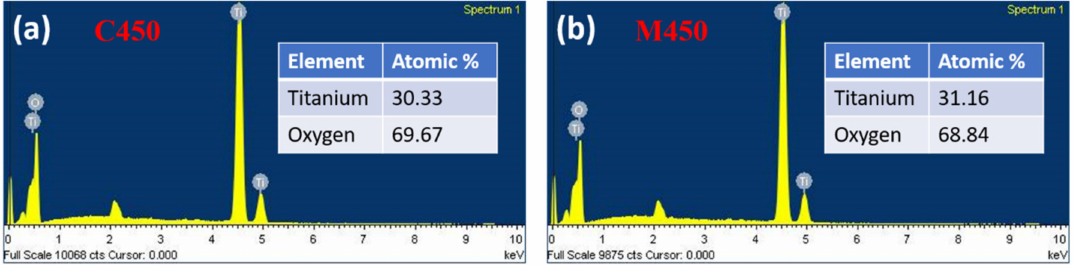
Figure 7. Energy-dispersive X-ray spectroscopy (EDS) of ( a ) Conventionally sintered titania, ( b ) Microwave sintered titania and their corresponding elemental atomic percentage is in the inset